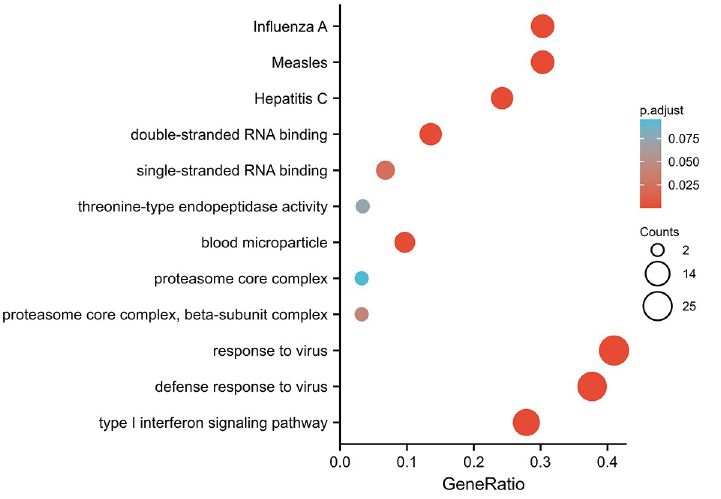
Fig 3. GO enrichment and KEGG pathway analysis of the overlapping 63 DEGs.